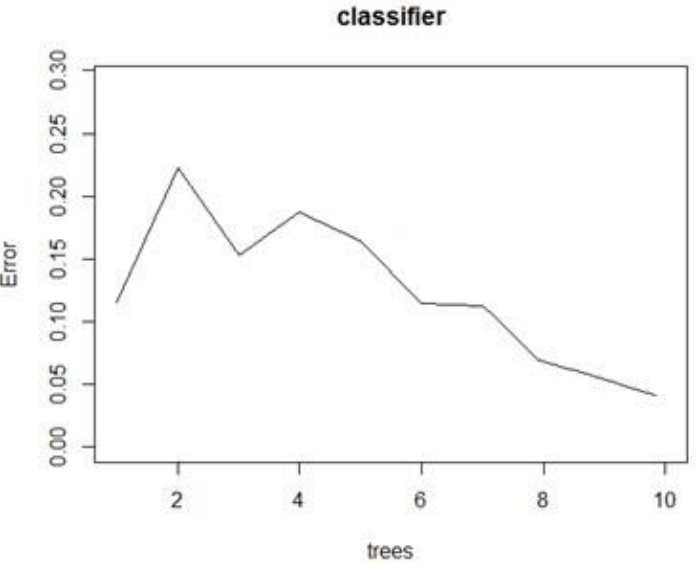
Figure 13. Estimated error vs. number of trees in the random forest algorithm.